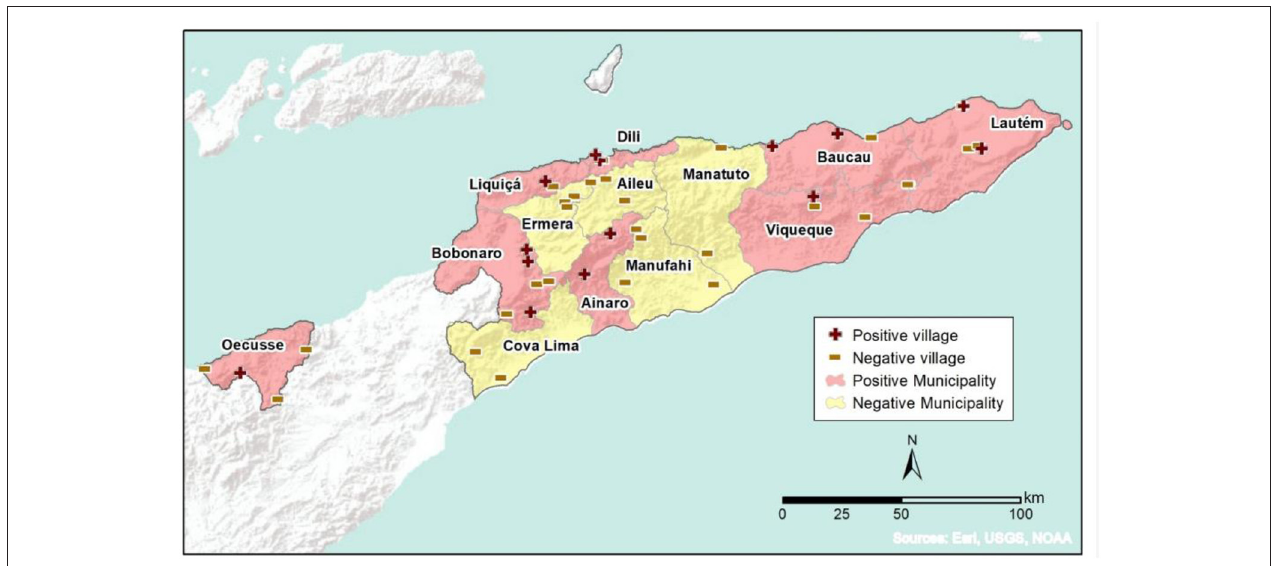
FIGURE 1 | Map of mainland prevalence survey